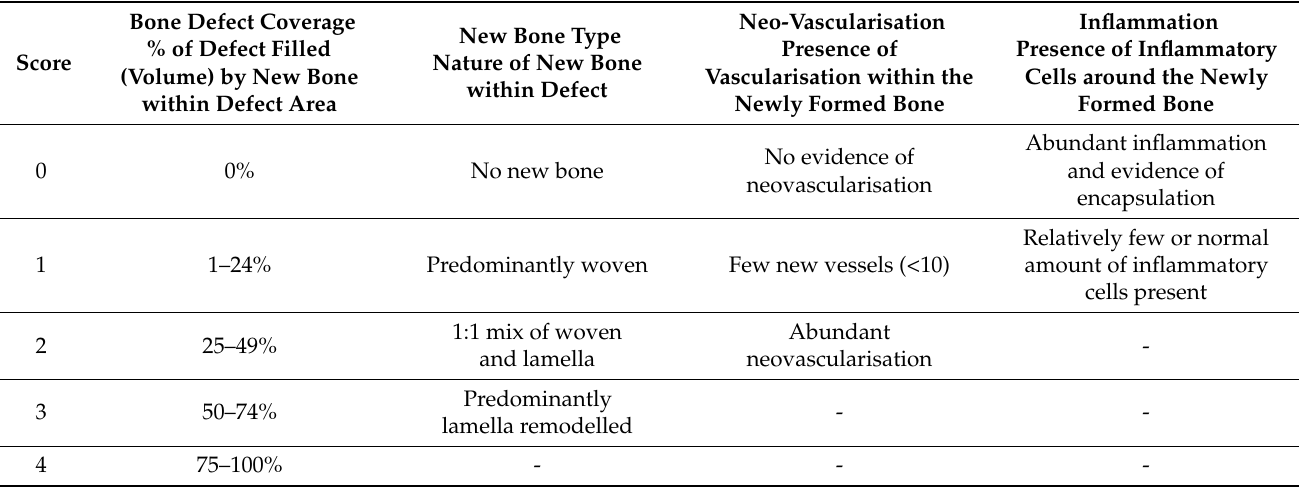
Table 1. Histology grading system used to semi-quantify outcomes of regenerated bone within defects modified from Musson et al. [32].